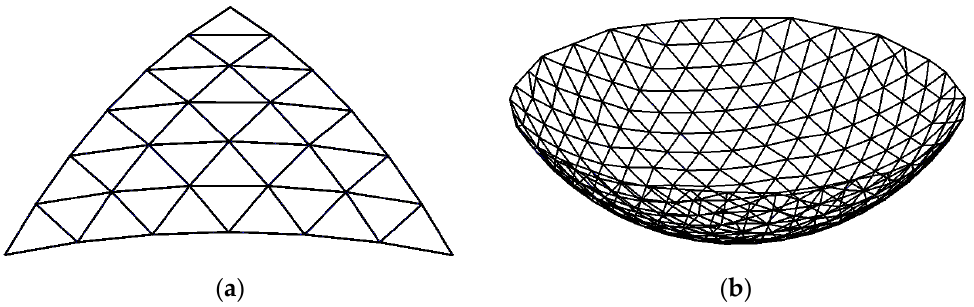
Figure 4. Diagram of spherical concentrator modularity ( R = 0.5 m, n c = 6): ( a ) Spherical triangle; ( b ) Top layer concentrator.